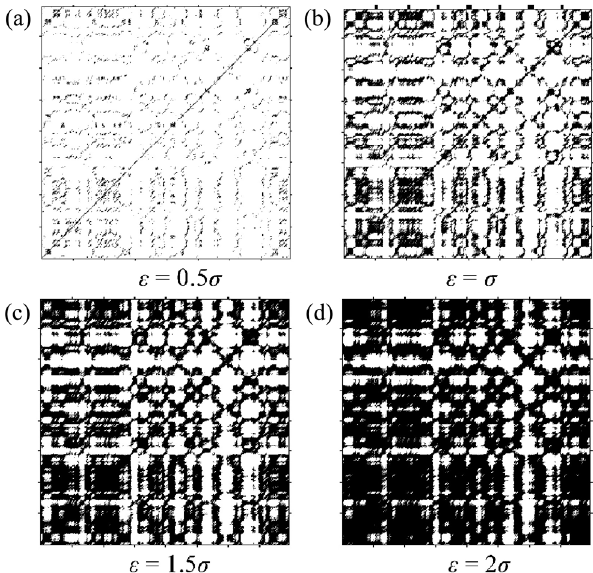
Fig. 5 RPs of the Lorenz time series dependent on cutoff distance ε ; σ is the variance of the given series.